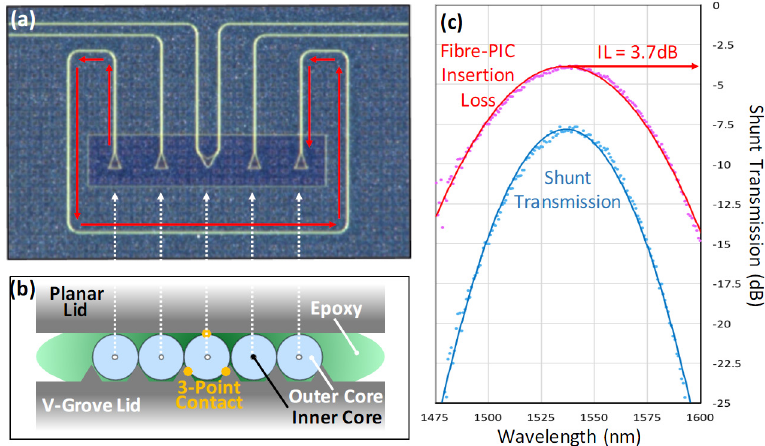
Figure 6. Optical shunt to support the active ‐ alignment of a multi ‐ channel fiber ‐ array to a Si ‐ PIC; ( a ) Microscope image of an optical ‐ shunt and three intermediate couplers—2 × 1D grating ‐ couplers, and 1 × 2D grating ‐ coupler); ( b ) Schematic of a multi ‐ channel fiber ‐ array showing how three ‐ point contact allows for precise alignment of the fibers in the v ‐ grooves; ( c ) The transmission spectrum of the optical ‐ shunt, showing the bandwidth of the grating ‐ couplers. As the shunt is symmetric and has negligible waveguide ‐ losses, the insertion ‐ loss (IL) in units of dB is simply half of the optical ‐ shunt transmission in units of dB.